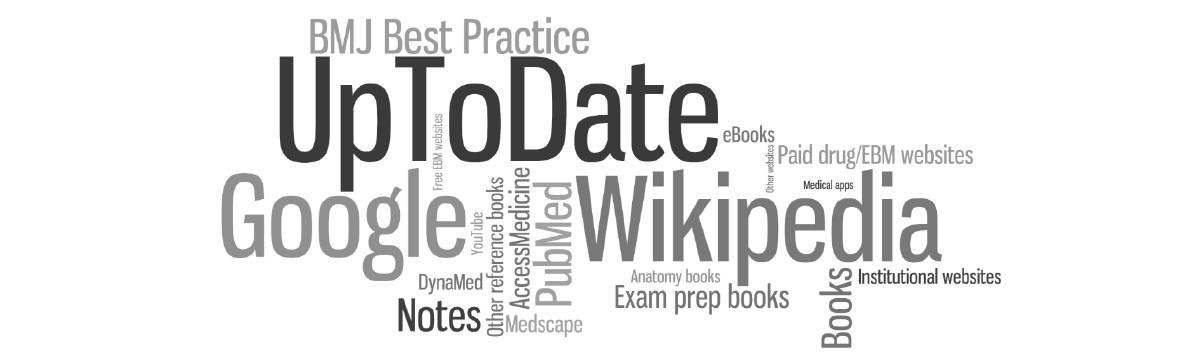
Figure 2. Student-identified top resources from the previous 7 days.